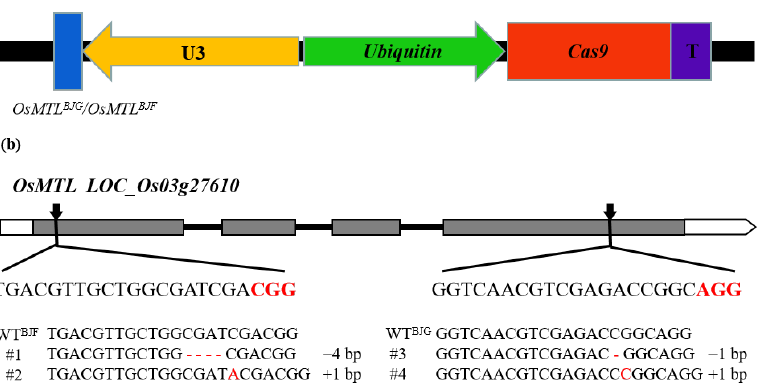
Figure 2. Knockout of OsMTL in Chunyou84 by the CRISPR-Cas9 system. ( a ) Schematic diagram of the structure of the CRISPR-Cas9 vector targeting OsMTL . ( b ) Targeted sites in OsMTL gene and mutations at the BJF and BJG loci in T 0 generation plants. Mutations with 1 bp insertions are indicated by red letters, and the deleted sequences are indicated by red hyphens.